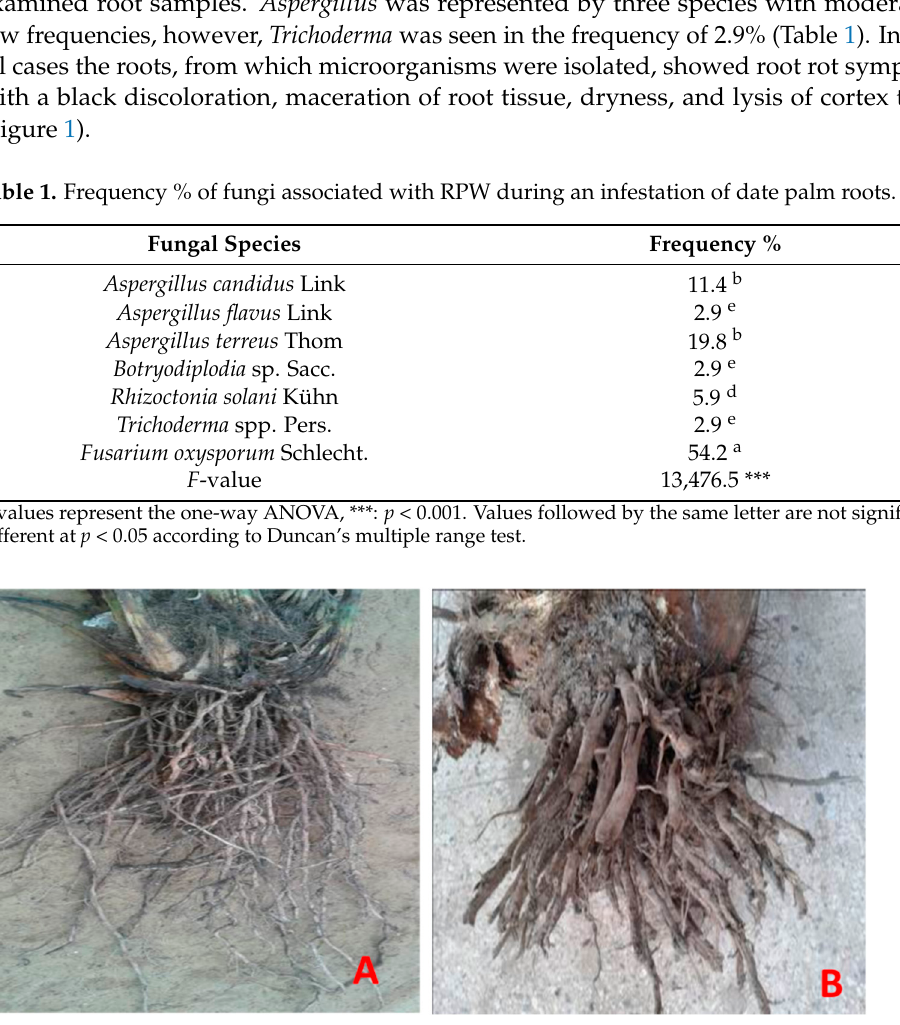
Figure 1. Root rot symptoms of date palm infested with the RPW. Healthy normal roots ( A ) and infested roots showing a black discoloration and maceration ( B ).